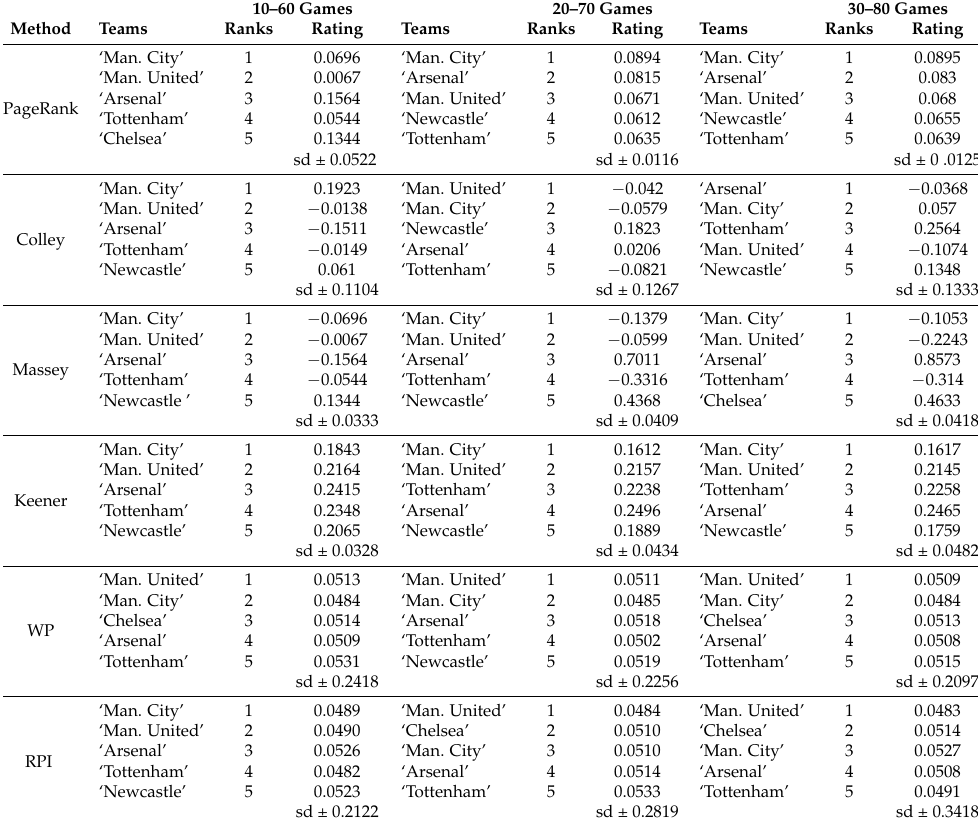
Table 1. Comparison of top-5 teams rate–rank by rolling window